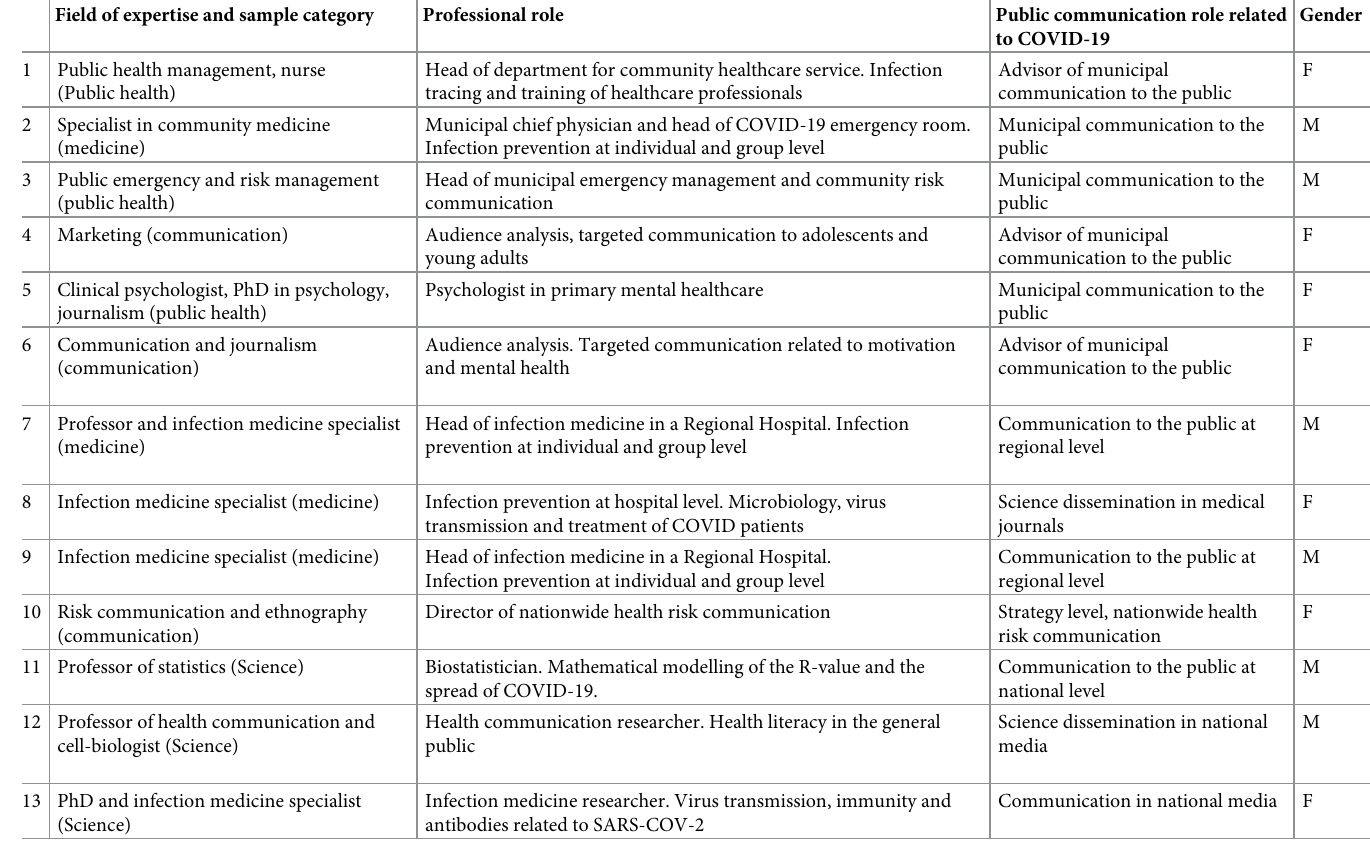
Table 1. Sample characteristics.